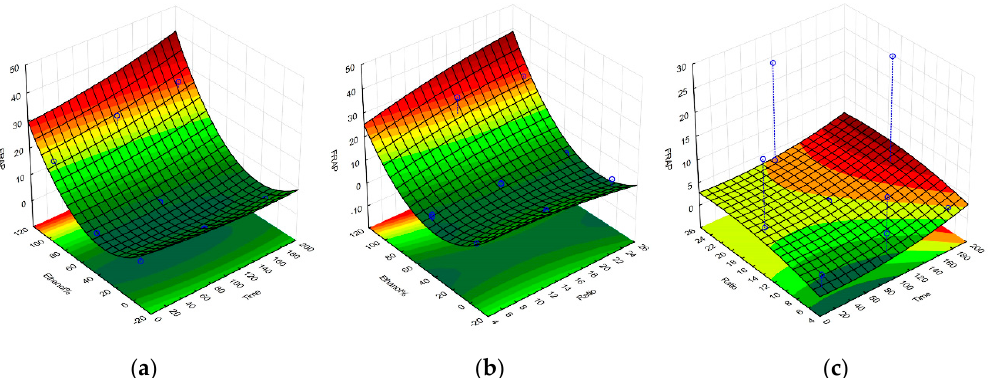
Figure 2. Response surface graphs for the model of the G. gracilis extractions, obtained for the TPC response upon variation of ethanol% and extraction time ( a ), ethanol% and solid-to-liquid ratio ( b ), and solid-to-liquid ratio and extraction time ( c ). Total phenolic content expressed in mg of gallic acid equivalents per g of dried extract. Time is expressed in minutes, and SLR (here displayed as Ratio) as solvent volume (mL) per one gram of dried seaweed.